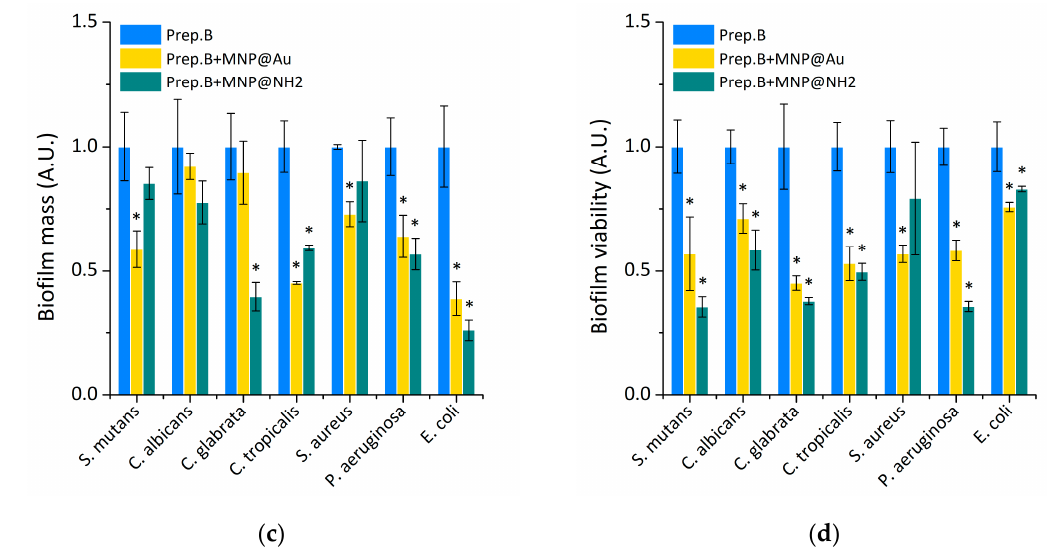
Figure 3. The addition of magnetic nanoparticles to artificial saliva preparations inhibits the growth and biofilm formation of selected oral pathogens. Panel ( a ) indicated the ability of tested formulations to restrict the proliferation of selected oral pathogens. Panels ( b , c ) show the ability of tested saliva preparations containing magnetic nanoparticles against the microorganism adhesion and the formation of biofilm. Decreased viability of the cells embedded in the biofilm matrix after treatment with tested saliva formulations containing magnetic nanoparticles is presented at panel ( d ). Statistical significance for the tested preparations, compared to control, was marked by (*) p ≤ 0.05. Results from three measurements ±SD.